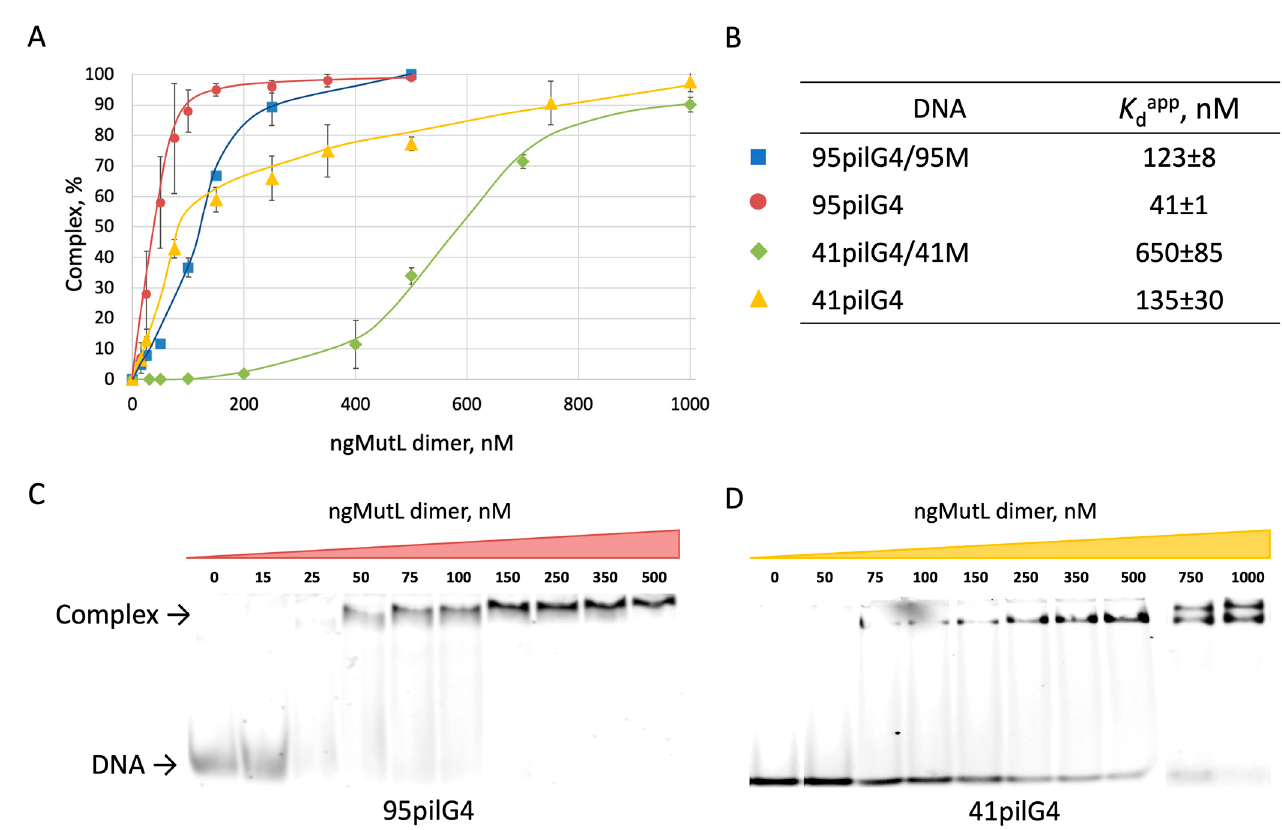
Figure 5. Binding of ngMutL to DNA ligands. The yield of nucleic acid–ngMutL complexes calculated from EMSA data ( A ). TAMRA-labeled DNA probes (20 nM) were incubated for 10 min on ice with 15–1000 nM ngMutL (per dimer) in 20 mM HEPES buffer (pH 8.0) containing 100 mM KCl, 0.5 mg/mL BSA, and 1 mM DTT. Reaction mixtures were analyzed by electrophoresis in 6% polyacrylamide gel in TAE buffer at 4 ◦ C. Error bars represent 95% confidence intervals. The calculation was carried out for at least three independent experiments. K dapp values of ngMutL complexes with single- and double-stranded DNA ligands ( B ). Typical electropherograms of ngMutL binding to 95pilG4 ( C ) and 41pilG4 ( D ).